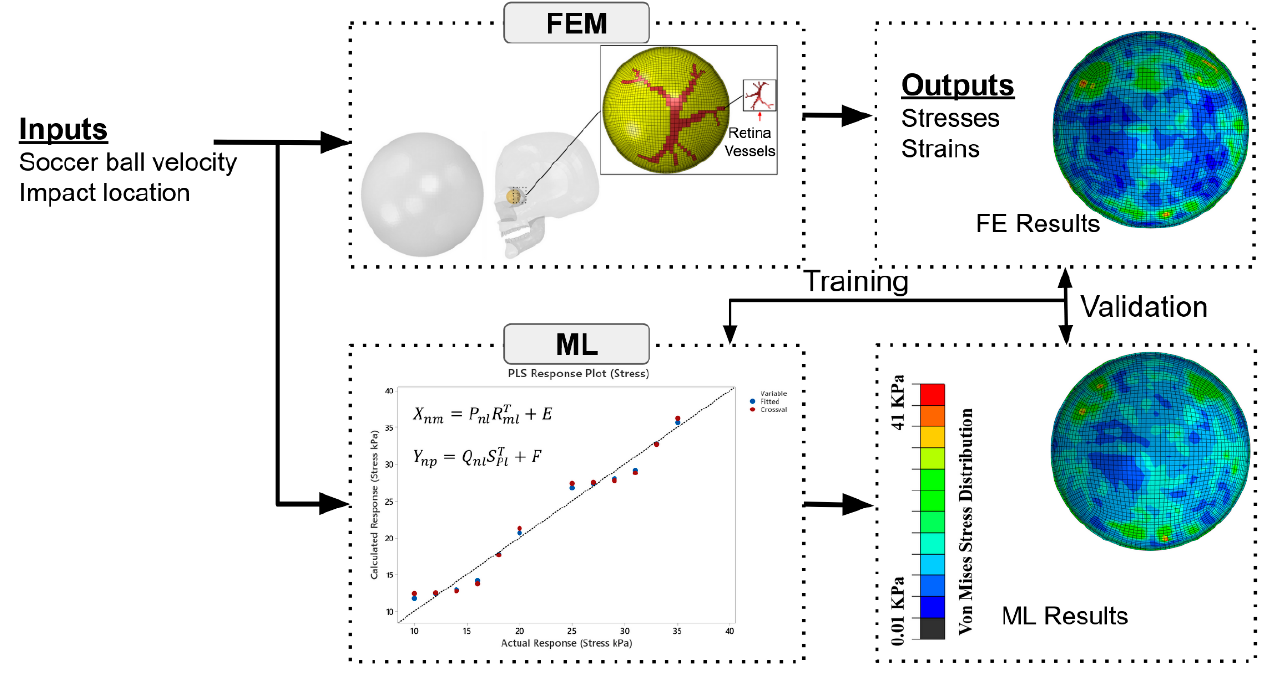
Figure 1. Overall framework to combine FE analysis with an ML method for rapidly predicting soccer-induced posterior retina stress/strain patterns.